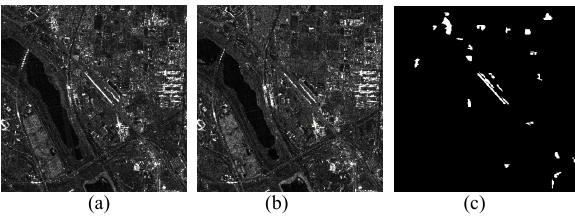
Figure 3. Yamenkou dataset. (a) Image acquired in April 2017. (b) Image acquired in May 2018. (c) Reference image. Area B is the Luchengxiang area of size of 400×400 pixels. Construction and demolition of artificial structures are the main cause of changes. Relevant images of Luchengxiang are shown in Figure 7.